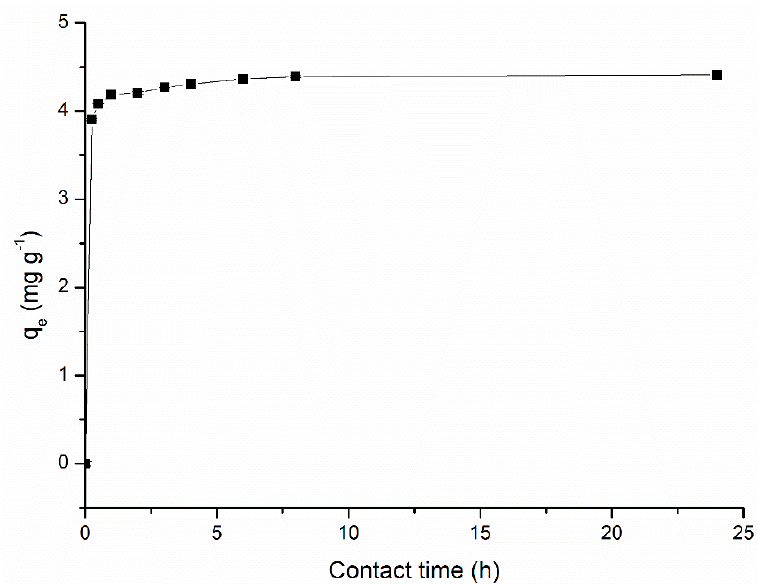
Figure 3. Kinetics adsorption (methylene blue (MB) concentration = 5.0 mg L − 1 , adsorbent concentration = 2.0 g L − 1 , particle size = 30 mesh, sample volume = 50 mL, contact time = 0–24 h, temperature = 25 °C, stirring speed = 150 rpm).